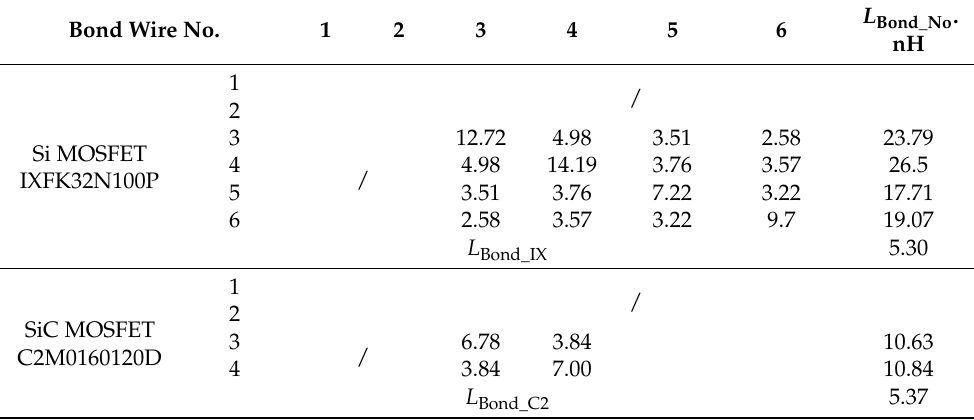
Table A1. Parasitic inductance, L Bond , with two bond wire cutoffs. Bond Wire